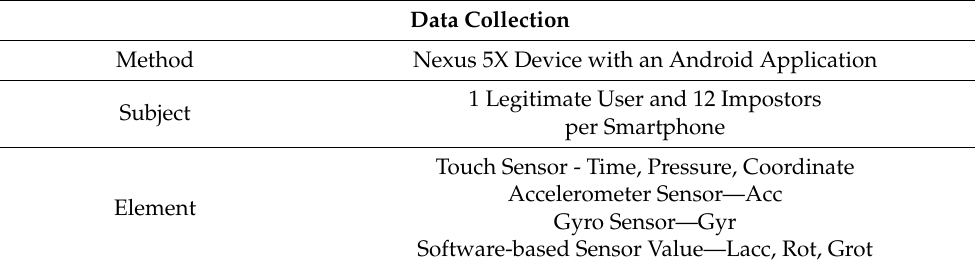
Table 1. Collection data element.